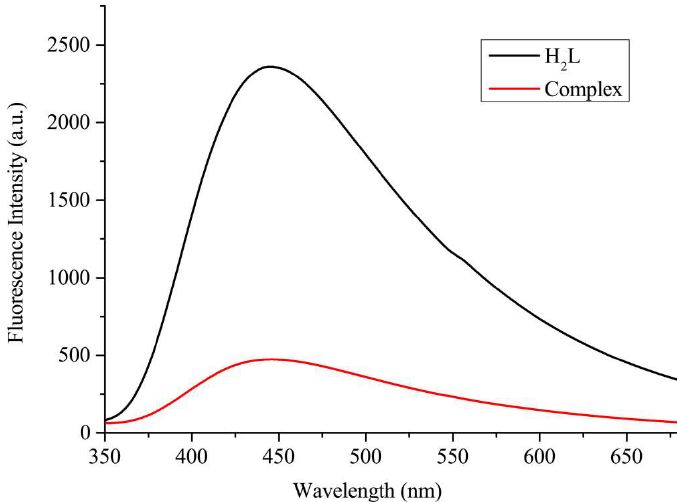
Figure 4. Luminescence spectra of H 2 L and its Zn II –Eu III complex in methanol (3.0 × 10 − 5 M) upon excitation at 352 nm.